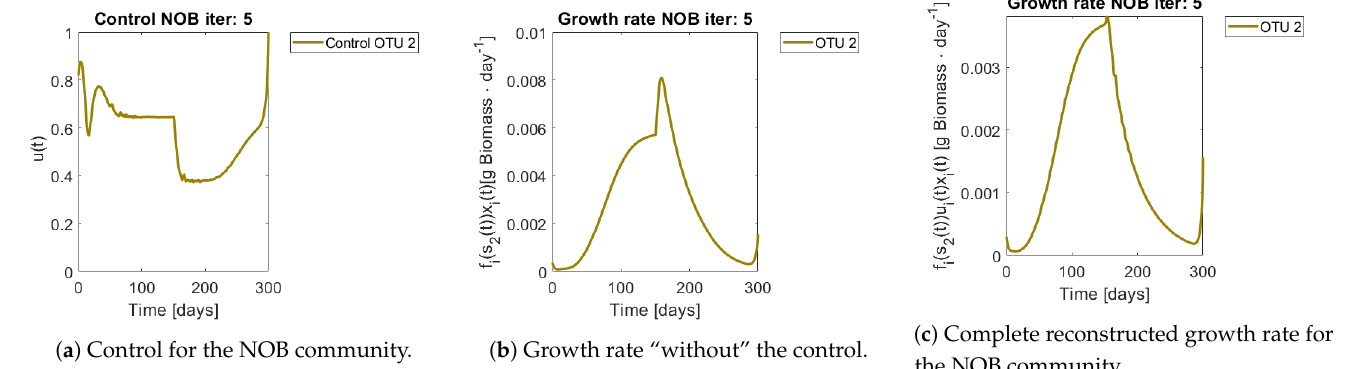
the NOB community.